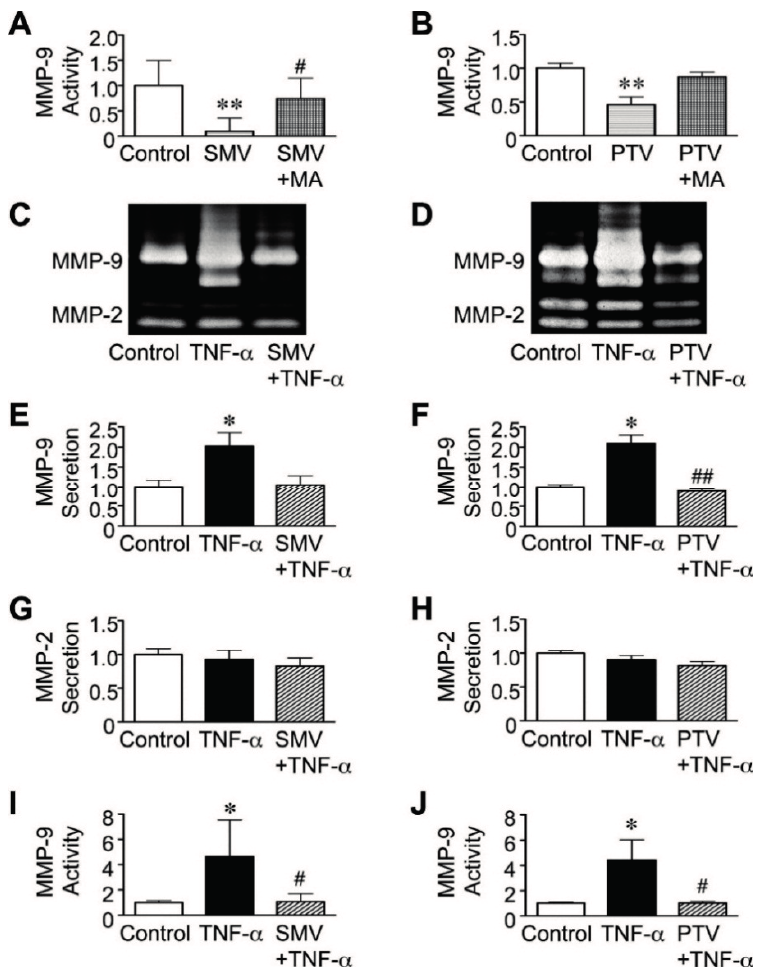
Figure 2. Effect of statins on matrix metalloproteinase (MMP)-9 secretion in human abdominal aortic aneurysm (AAA) wall. A human AAA wall was cut into small pieces and cultured with simvastatin (SMV, 10 μ M), pitavastatin (PTV, 20 μ M), mevalonate (MA, 100 μ M), tumor necrosis factor (TNF)- α (50 ng/mL) or vehicle (control). ( A , B ) Levels of MMP-9 activity in the conditioned media were analyzed ( n = 5). Data are the mean ± standard deviation (SD). ** p < 0.01 compared to the control; # p < 0.05 compared to SMV; ( C – H ) Levels of MMP-9 and MMP-2 in the conditioned media were determined by zymography ( n = 5). Data are the mean ± SD. * p < 0.05 compared to the control; ## p < 0.01 compared to TNF- α ; ( I , J ) Levels of MMP-9 activity in the conditioned media were analyzed ( n = 5). Data are the mean ± SD. * p < 0.05 compared to the control; # p < 0.05 compared to TNF- α